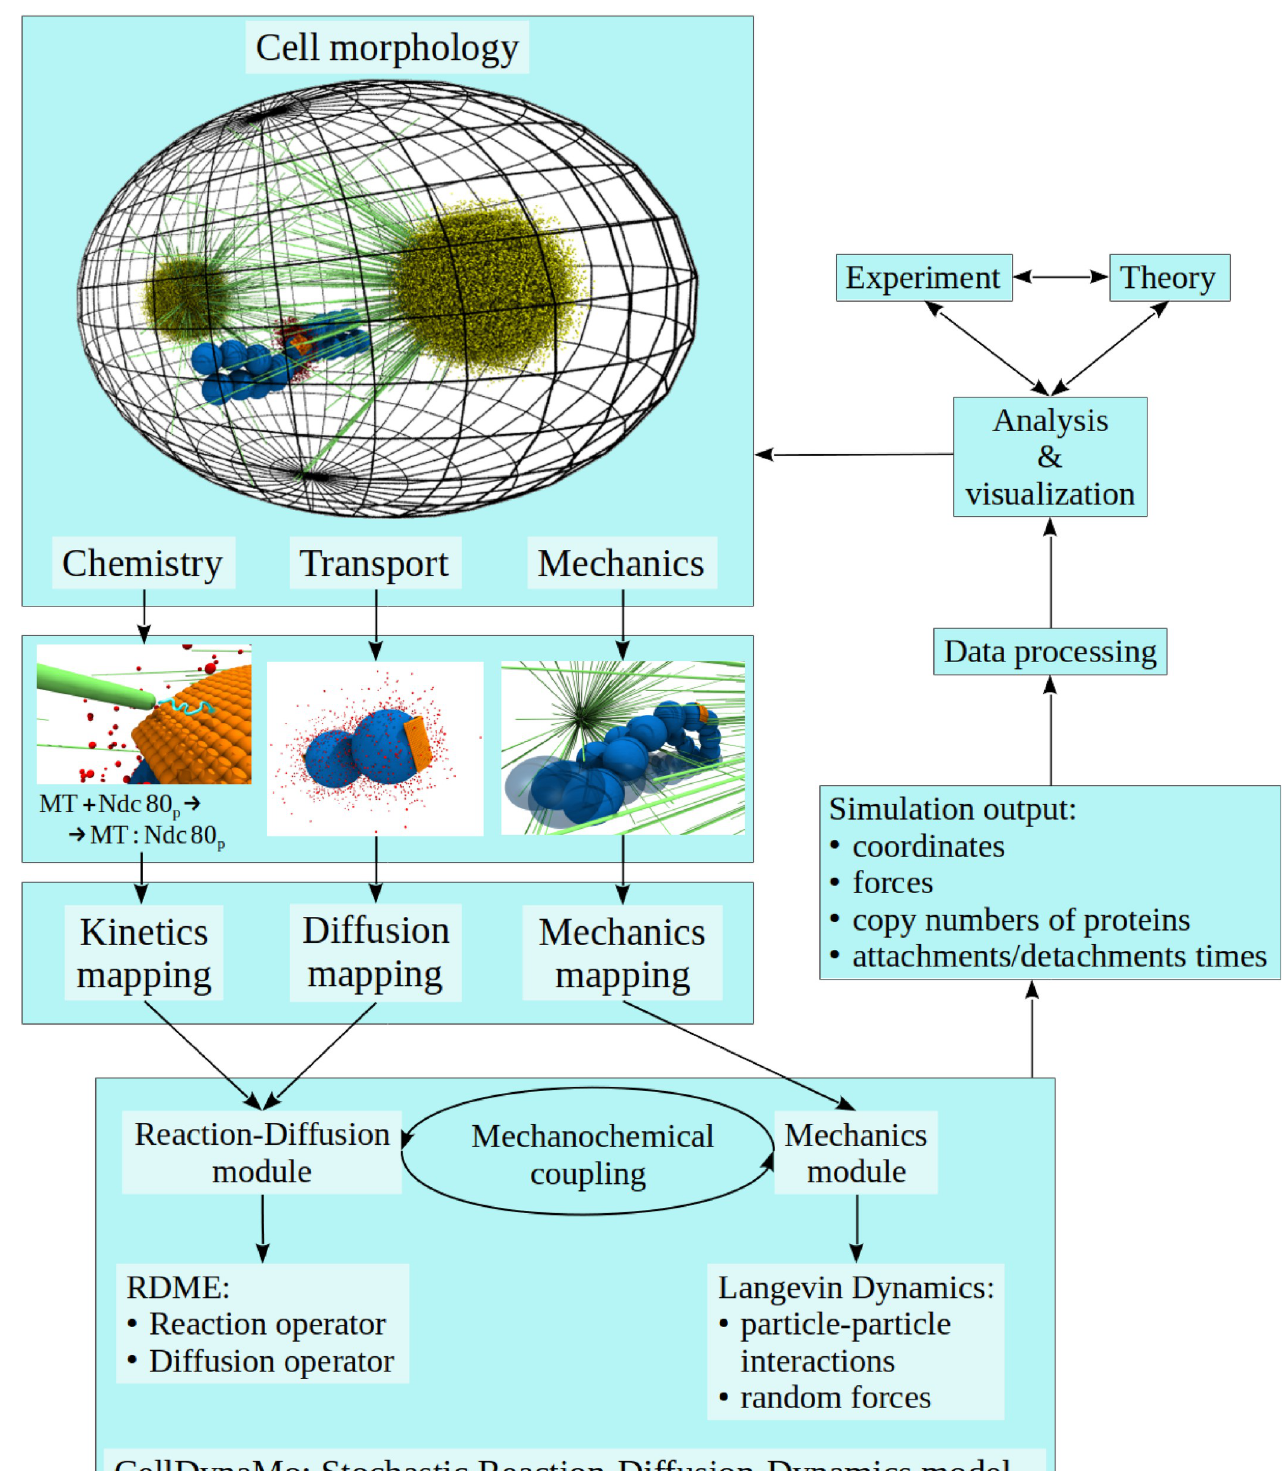
Fig 3. Design of Stochastic Reaction-Diffusion-Dynamics model-based implementation of CellDynaMo package. CellDynaMo requires the initial input (reaction rate constants, copy numbers of biomolecules), the force field parameters (stretching and bending rigidities, KT-MT attachment strength), and cell morphology (number of chromosomes or kinetochore pairs, membrane shape). These specify cell morphology and geometry of spatial arrangements of